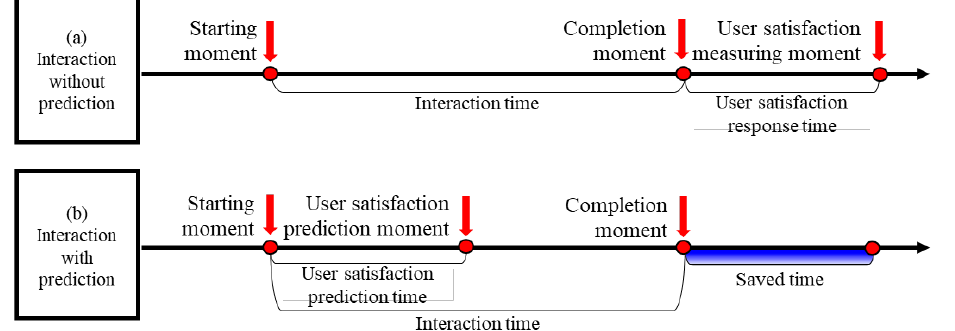
Figure 2. Example of saved time when applying prediction: ( a ) interaction without prediction, ( b ) interaction with